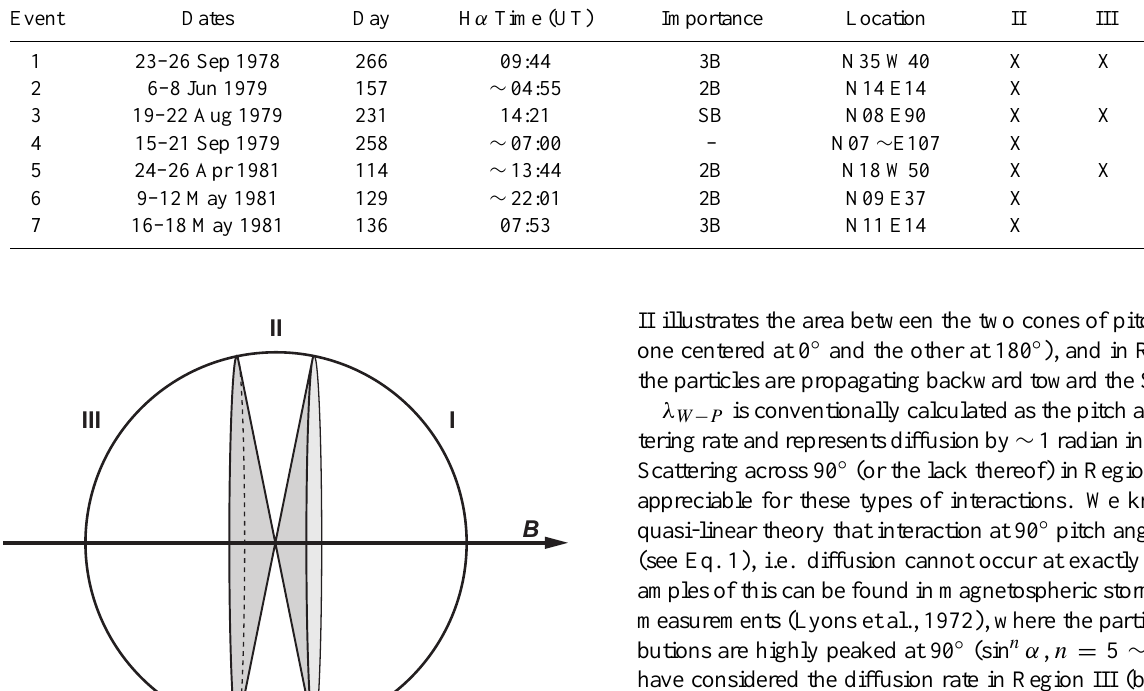
Table 5. High-intensity solar particle events Event onset Radio bursts